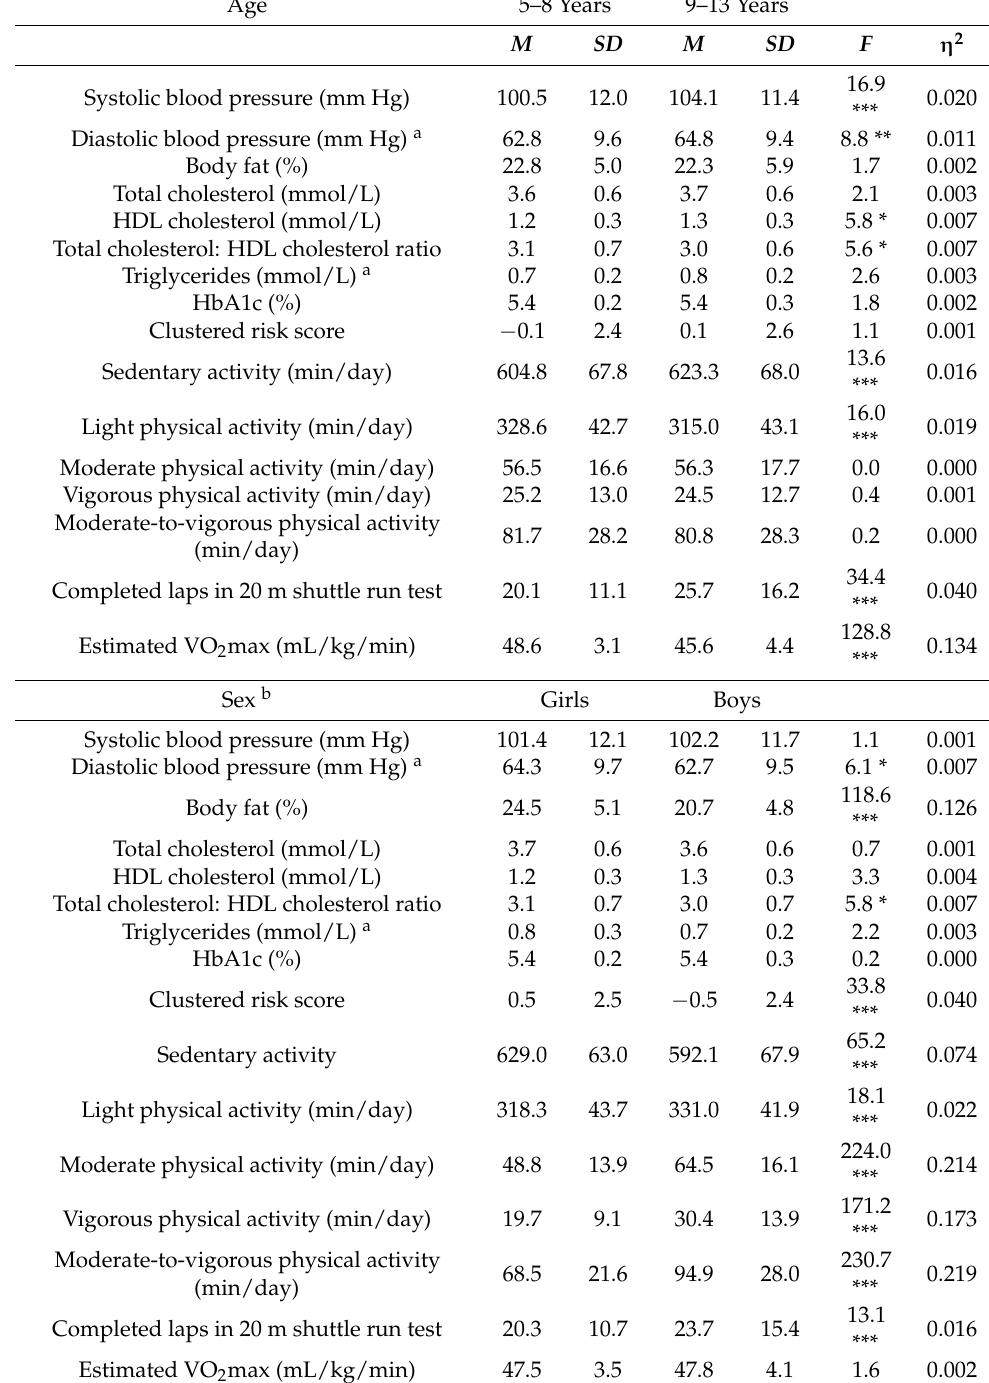
Table 2. Differences in outcome and predictor variables, based on children’s age and